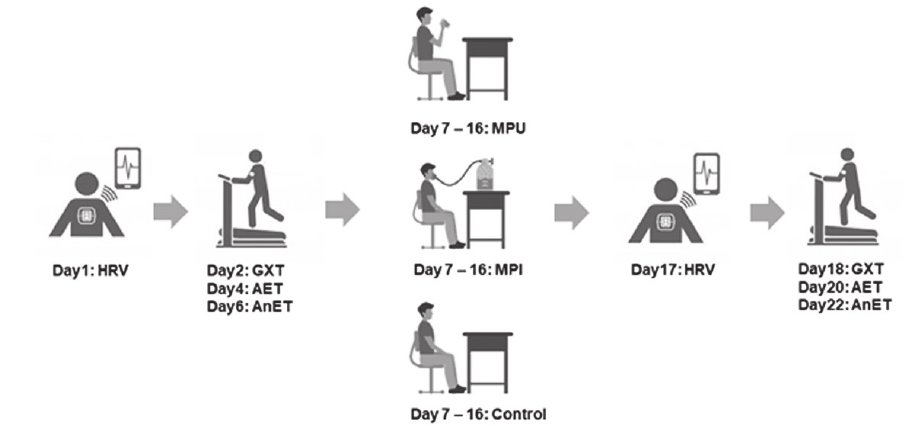
Figure 1. Experimental design of this study. HRV: heart rate variability; GXT: Graded exercise